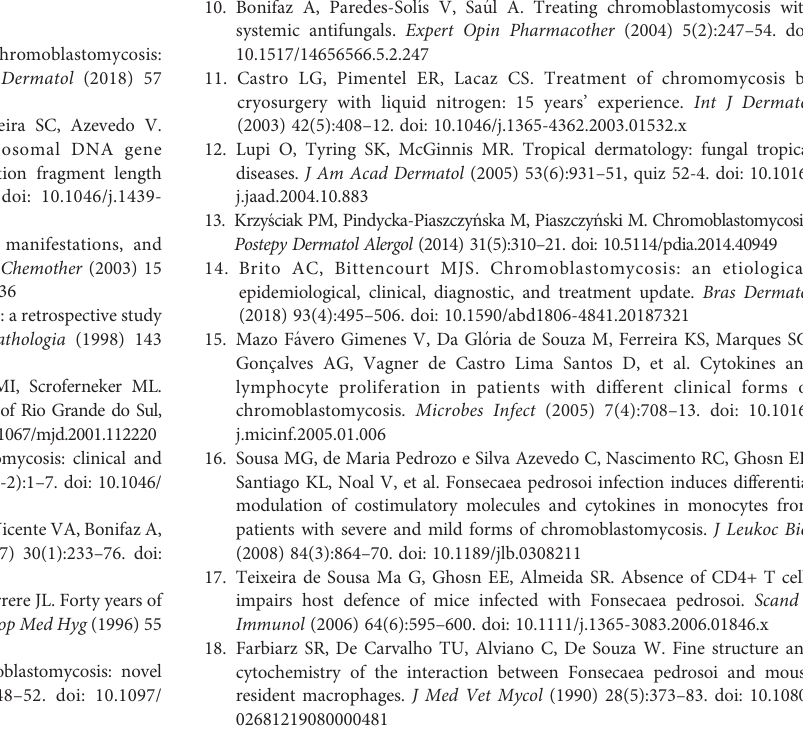
SUPPLEMENTARY FIGURE 6 | NET release in F. pedrosoi hyphae infection is a mechanism independent of NADPH oxidase. WT neutrophils were resuspended in media containing 5µM sytox green dye in resting condition (dashed lines; negative control)orincubated with PMAor F. pedrosoi hyphae in the presence orabsence of 20 m M DPI. After 180 mins, fl uorescence was measured and the NETotic index was calculated. In the presence of DPI (20 m M) NET release was deeply inhibited in PMA but not in hyphae-stimulated neutrophils. Data are expressed as mean ± SEM; n